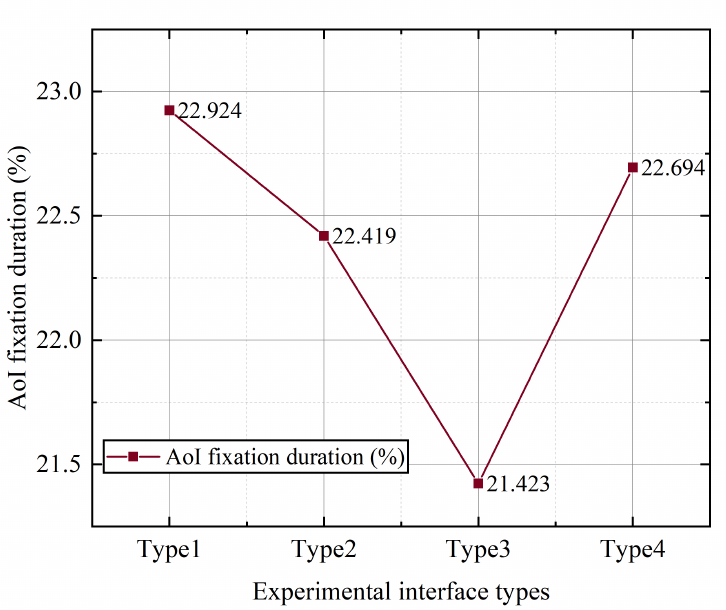
Figure 3. The average value of the ratio of the gaze duration of different styles of buttons.